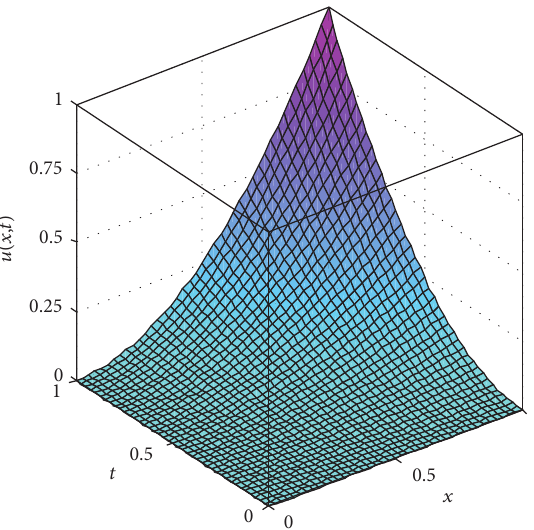
Figure 3: Numerical solution with 𝑚 = 10 for Example